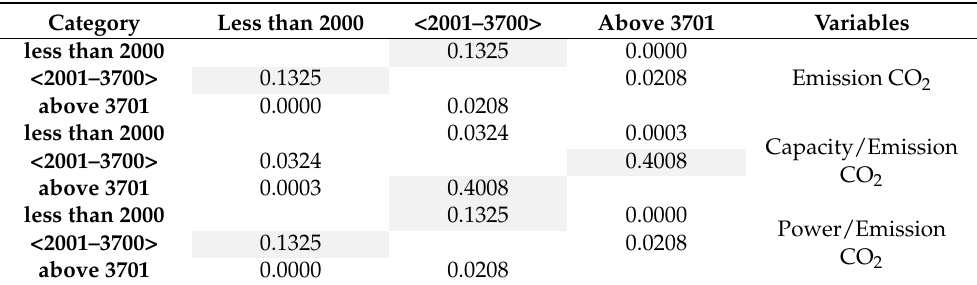
Table 5. p -values for differences in the levels of the variables tested by engine displacement categories of American-made cars.